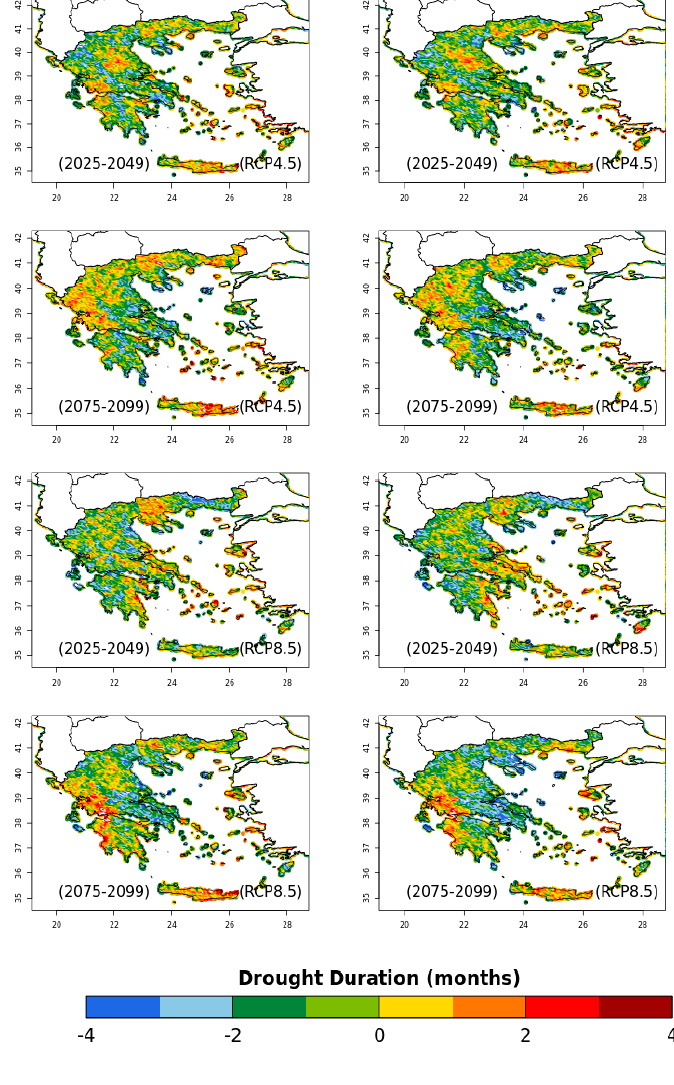
Figure 4. ( a ) Drought duration as the averaged values obtained for the entire reference period (1980–2004) for the SPI and the SPEI indices computed at a 6-month timescale. ( b ) Changes in the duration for the 6-month SPI and SPEI for the near future period (2025–2049) and the far future (2075–2099) relative to the reference period (1980–2004) under RCP4.5 and RCP8.5.